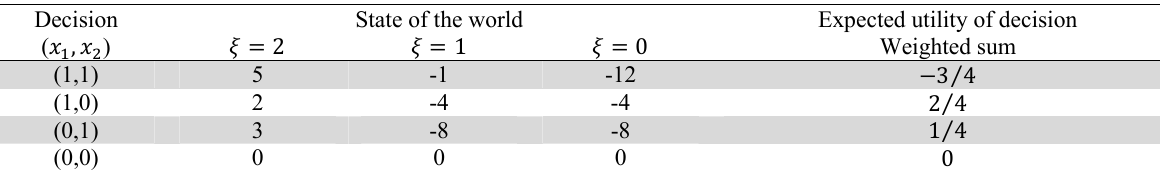
EUP calculations